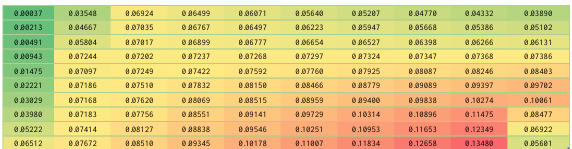
Table 4. Maximum distances of the fitting straight lines on